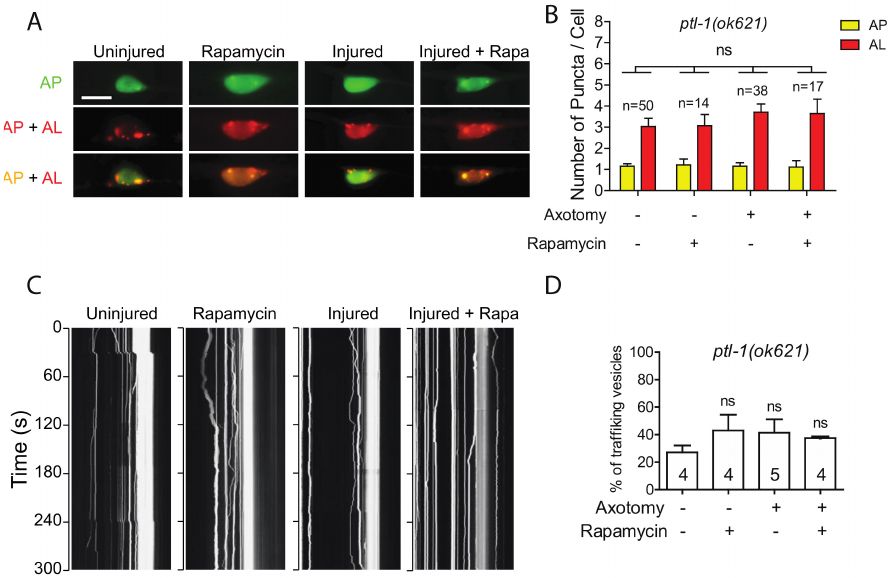
Figure 5. Defective autophagic induction and tra ffi cking in ptl-1 mutant. ( A , B ) Representative images and quantification of APs and ALs in PLM cell bodies of ptl-1(ok621) expressing P mec-4 -mCherry::GFP::LGG-1 with indicating treatment. Rapamycin treatment did not rescue the autophagic activity in PLM neurons of the ptl-1 mutant animals. Scale bar: 10 µ m. ( C )